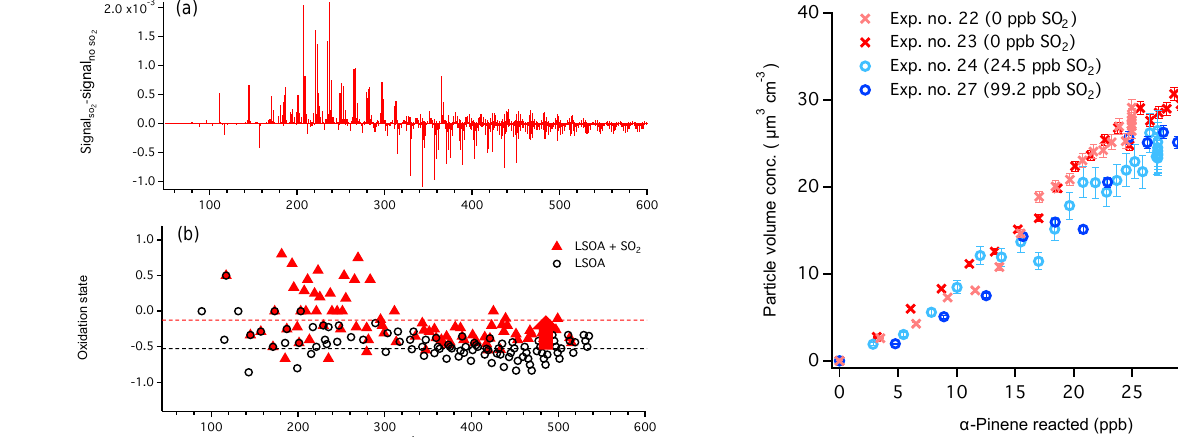
Figure 6. Difference of normalized mass spectra between LSOA in the presence and absence of SO 2 (a) . Signal of HSO − was excluded such that only organic mass spectra are com- pared. (b) The average carbon oxidation state of each peak de- tected in IMS-TOF and the overall average carbon oxidation states of LSOA (black dashed line) and LSOA + SO 2 (red dashed line).